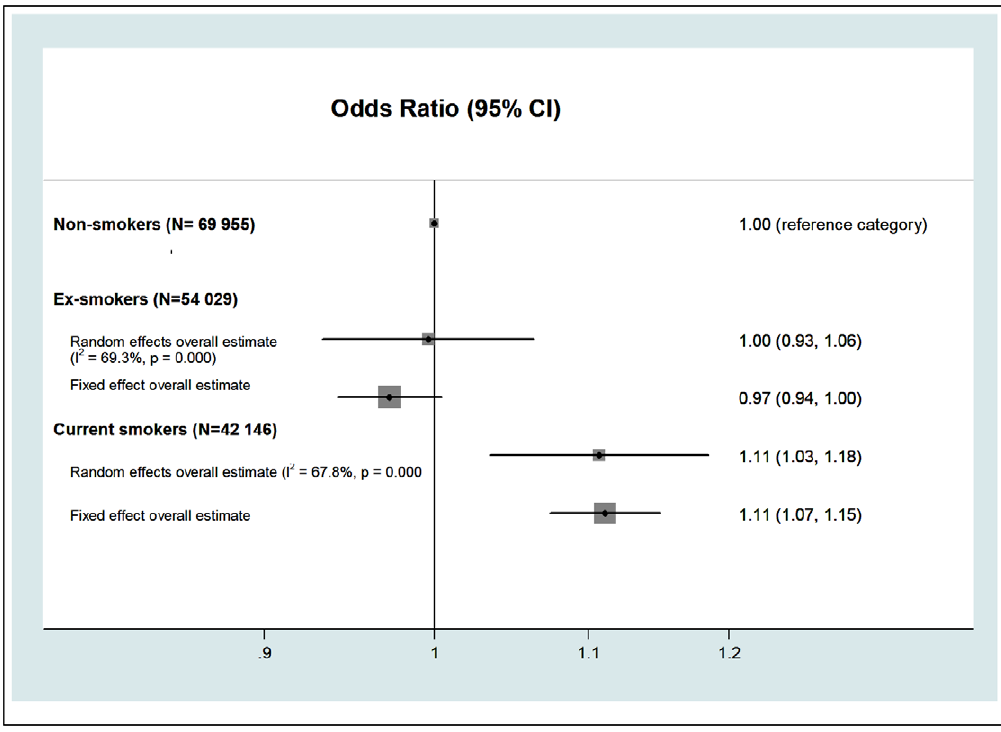
Figure 1. Association of tobacco smoking and job strain (adjusted for age, sex and socioeconomic status) (N =166 130).